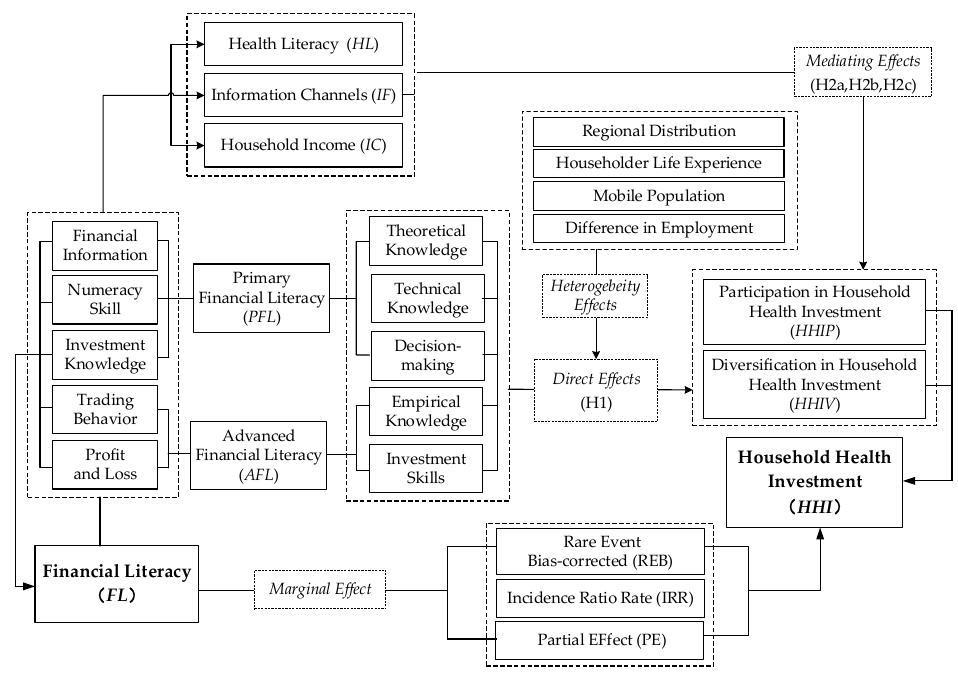
Figure 2. Diagram of the mechanism.